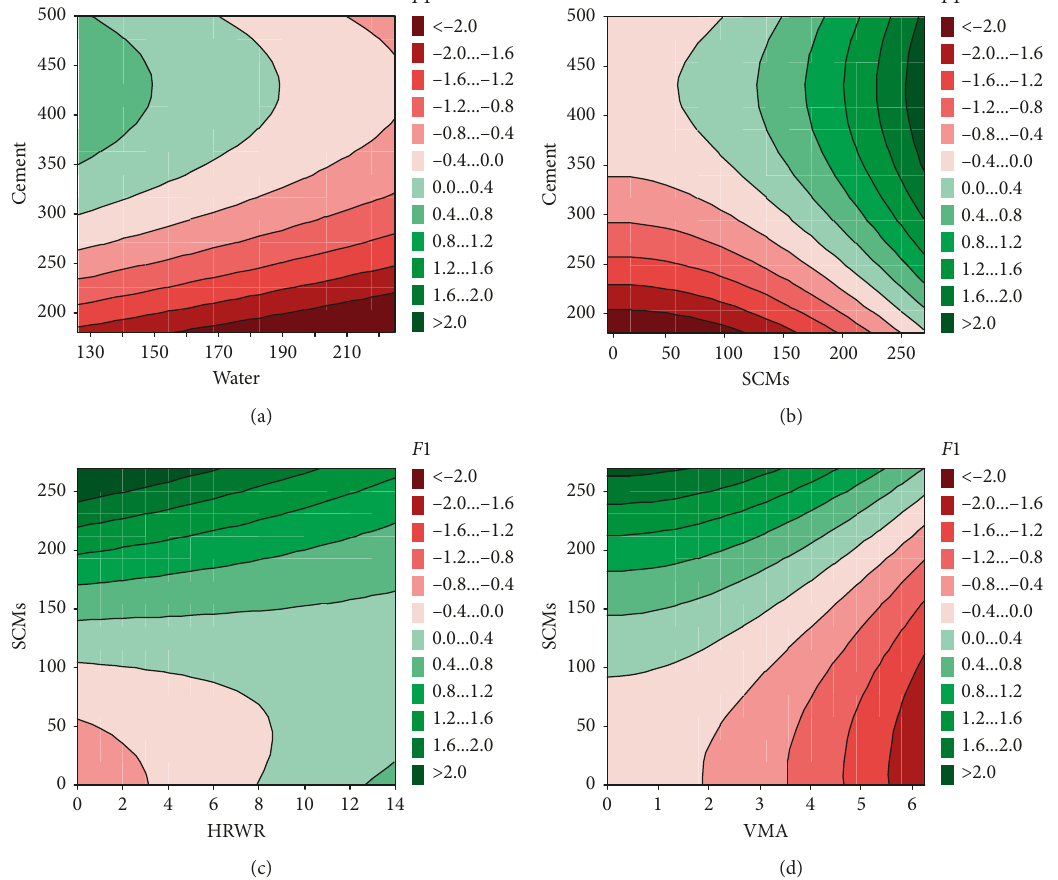
Figure 3: Effect of the paste composition on the quickness of the flow ( F